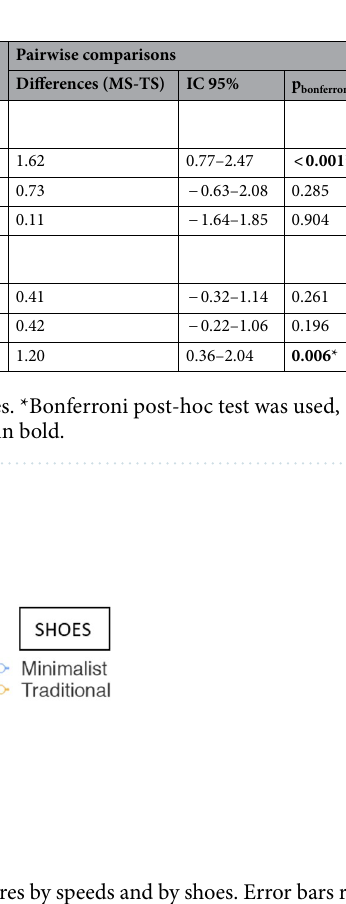
Table 2. The variations of the scores were due in 93% to the speed factor, F (1.25, 21,912.82) = 703.79, p < 0.001, ηp2 = 0.93, finding significant differences in all the comparisons between the three speeds. No main effect of shoes on femur ROM was found, F(1,50) = 1.95, p = 0.169, ηp2 = 0.04. However, the pairwise analysis revealed differences between the shoes at the speed of 6 km/h (Table 2). The range of the femur at 6 km/h was greater with